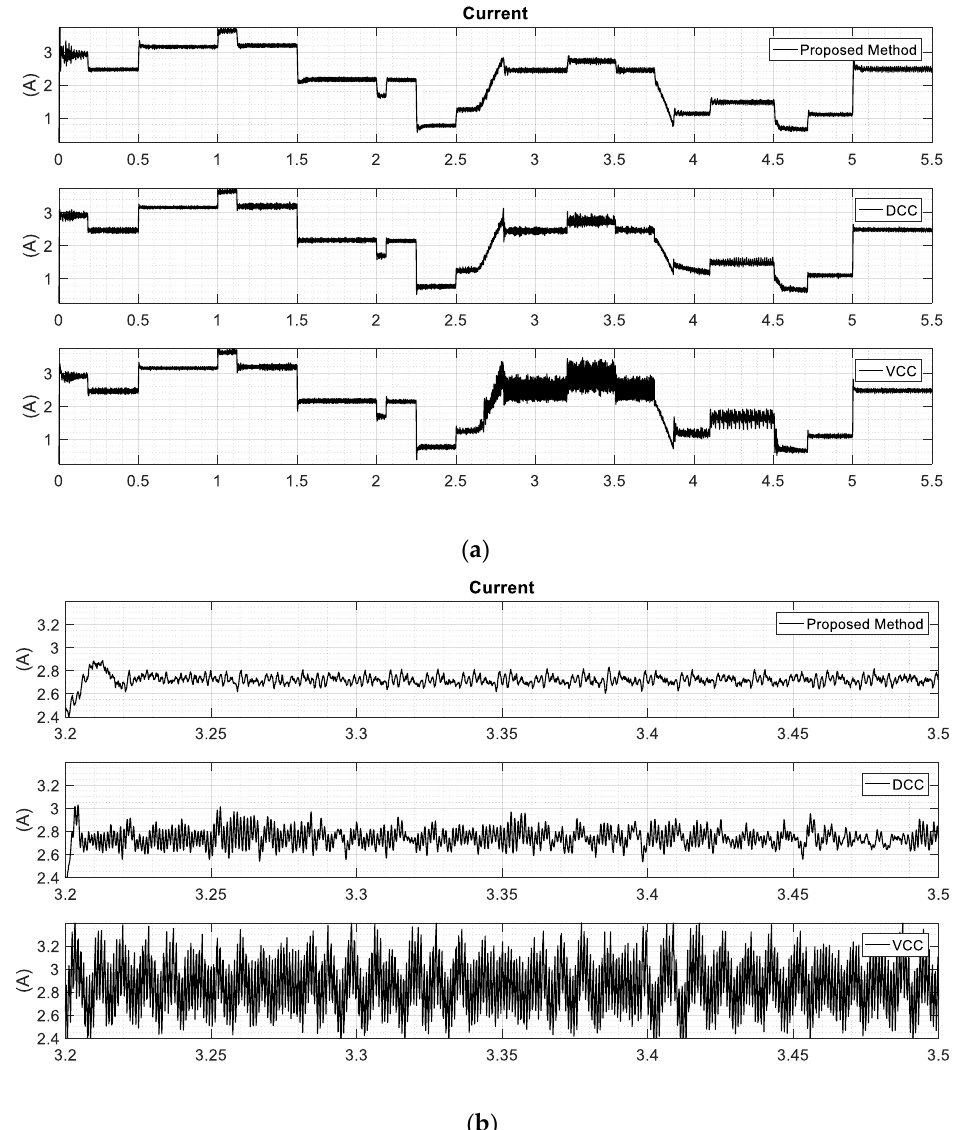
Figure 11. Comparative current results of PMSM in ( a ) full simulation time range and ( b ) interval time of (3.2 – 3.5 s).